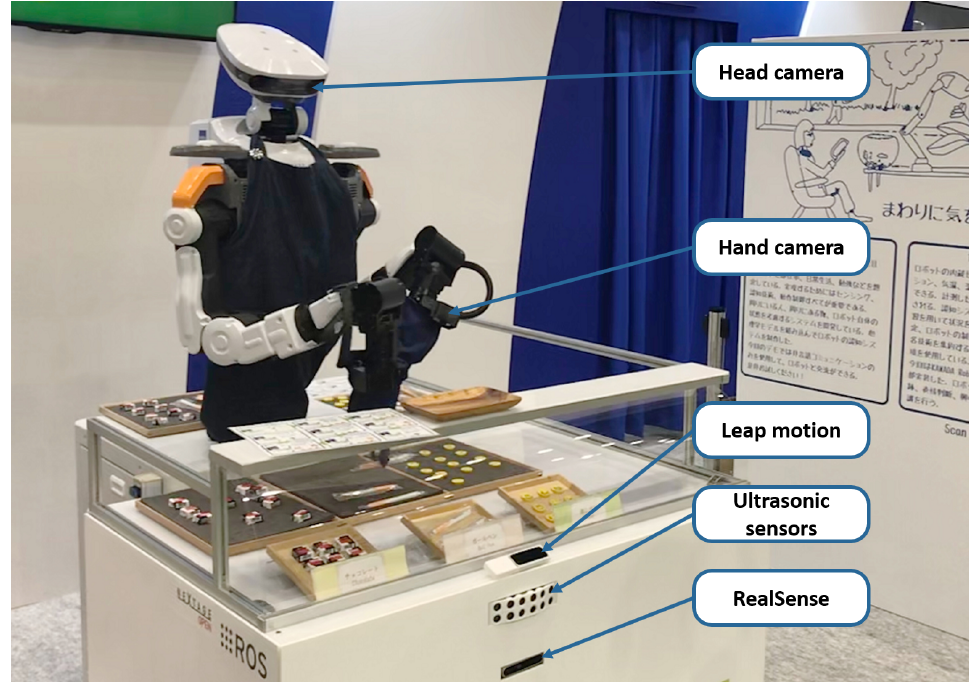
Figure 1. Robot on the